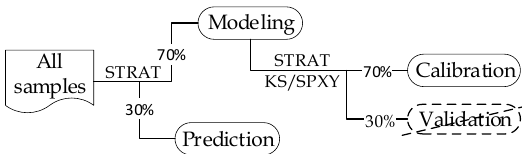
Figure 4. Strategy of sample subset partition.